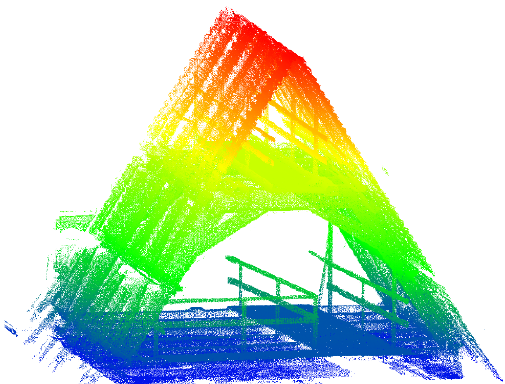
Figure 11: Point cloud of the roof construction in the